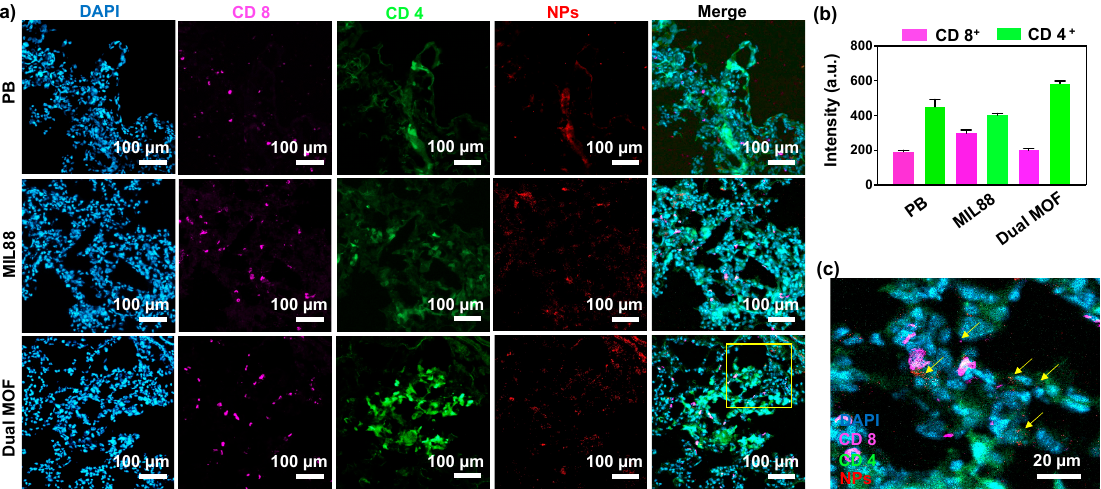
Figure 6. In vivo study of mice bearing B16F10 lung metastases treated with PB, MIL88, and dual MOF. ( a ) CLSM images of lung expressing CD4 + and CD8 + after treated with PB, MIL88, and dual MOF. Purple and green florescence represents CD4 + and CD8 + expressed cells. ( b ) Quantification of CD8 and CD4 expression by image J software. ( c ) The enlarged CLSM image of lung treated by dual MOF.